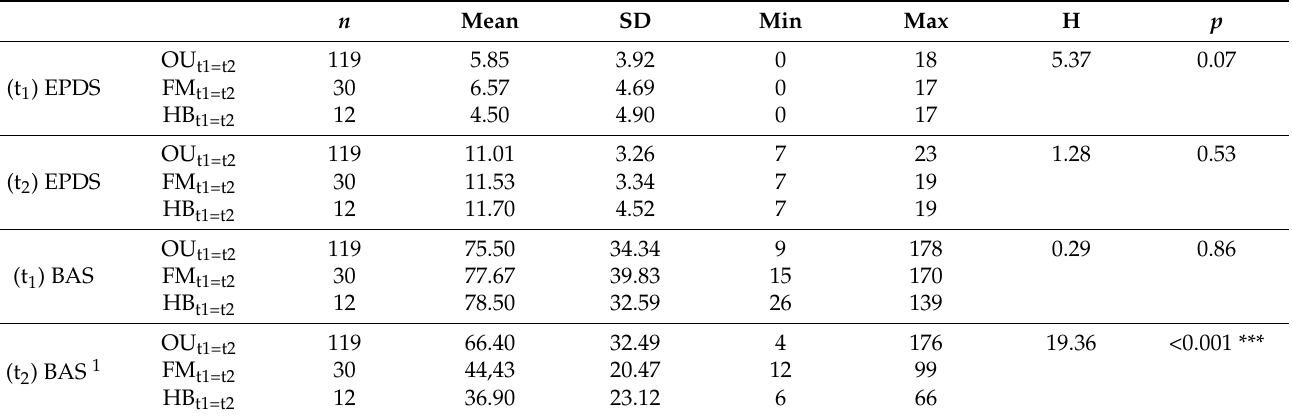
Table 4. Association between depressive symptoms, birth anxiety scores and actual birthplace of women who gave birth at planned birthplace (antepartal (t 1 ) and postpartal (t 2 )).